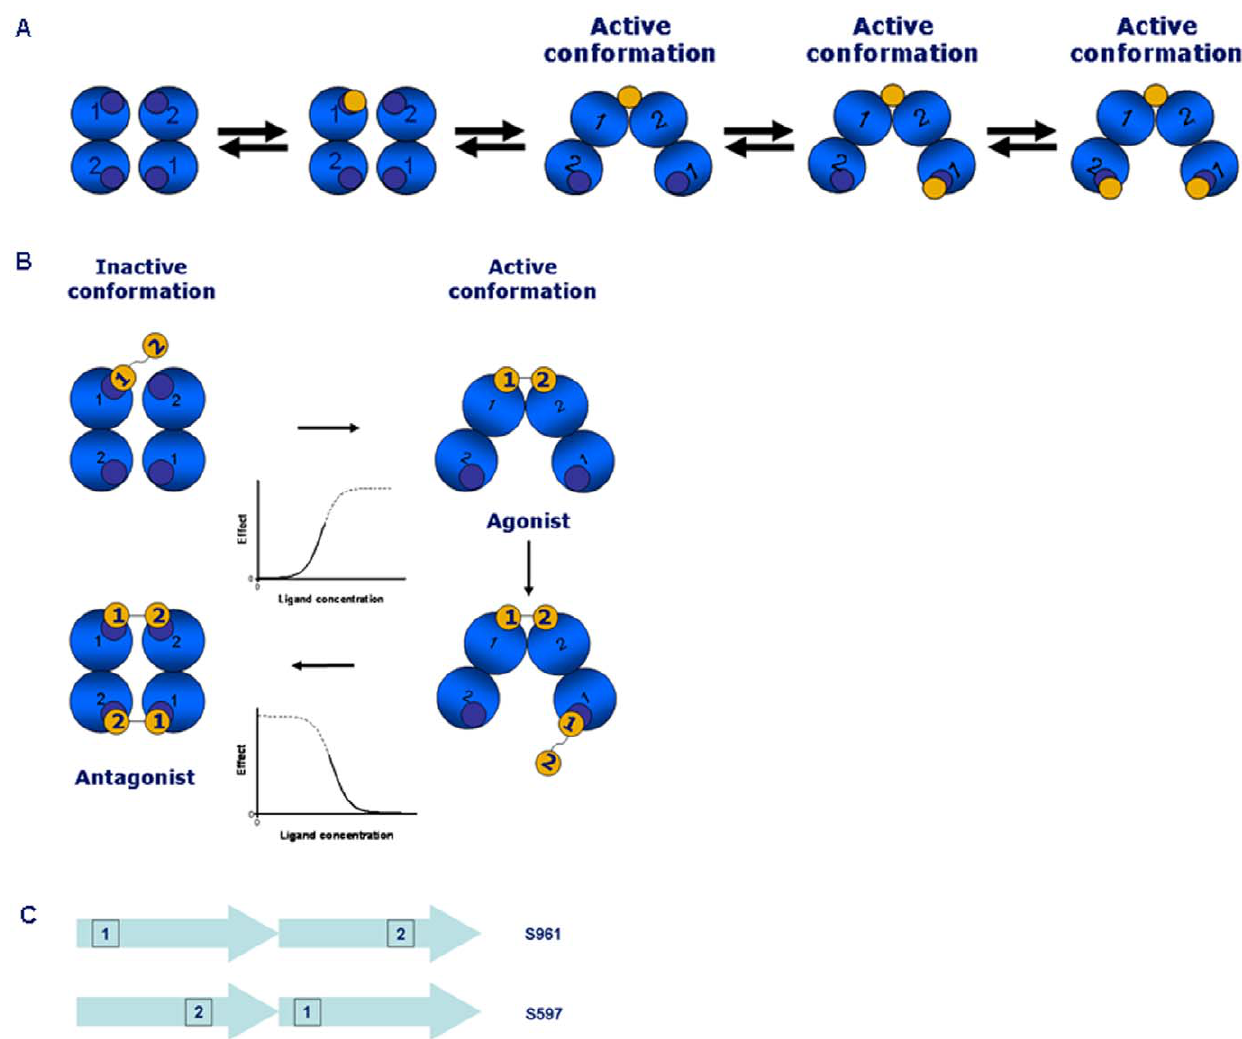
Figure 6. Current model of IR activation and proposed binding mechanism for S961. A . Current model of IR activation. The four blue circles represent the receptor binding sites (sites 1 and 2) seen from a top view. Insulin is depicted as a yellow circle. For a detailed explanation of binding sites 1 and 2, see [24]. B . Proposed binding mechanism for S961. The four blue circles represent the receptor binding sites (sites 1 and 2) seen from a top view. For a detailed explanation of binding sites 1 and 2, see [24]. The S961 peptide (Site 1–2 peptide) is shown as two connected yellow circles. At concentrations of 1–10 nM, S961 crosslinks the receptor, leading to agonist activity. At concentrations of above 10 nM, the higher flexibility of S961 in comparison to the insulin molecule allows simultaneous crosslinking of both pairs of binding sites, leading to an inactive conformation and antagonism. The corresponding activation and inactivation sigmoids are also shown. C . Orientation of peptide binding sites. If site 1 is located N- terminally and site 2 C-terminally, a longer distance between the binding sites in S961 in comparison to S661 can be